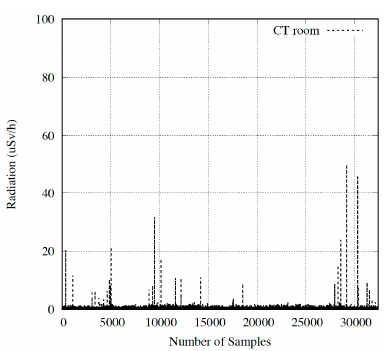
Figure 24. Results in room next to CT room.